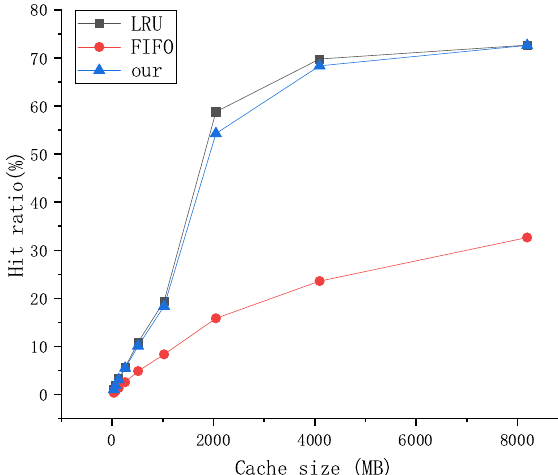
Figure 13. Hit rate under different cache sizes.